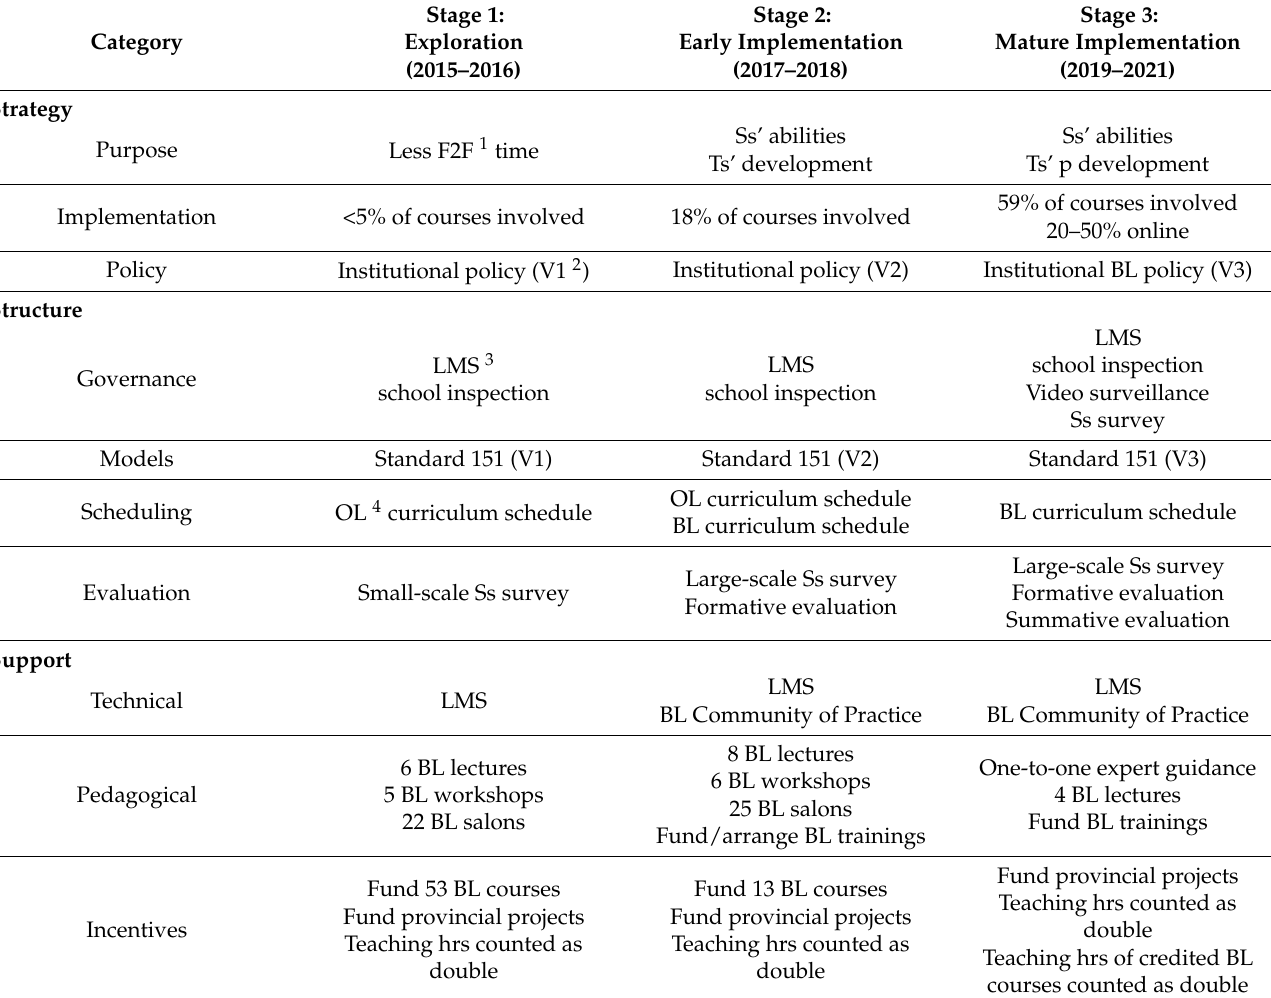
Table 1. S university’s institutional BL reform